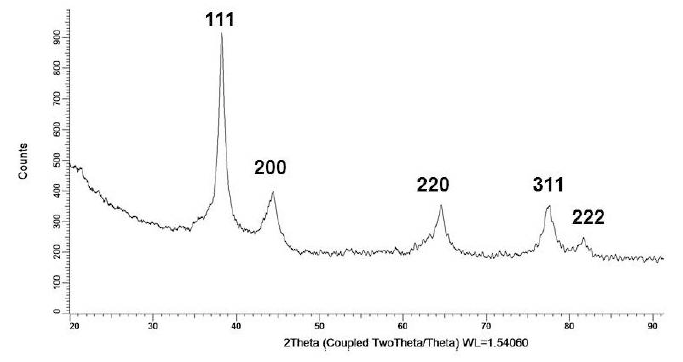
Fig. 2. X-Ray diffraction pattern of AgFe nanoparticles by chemical reduction